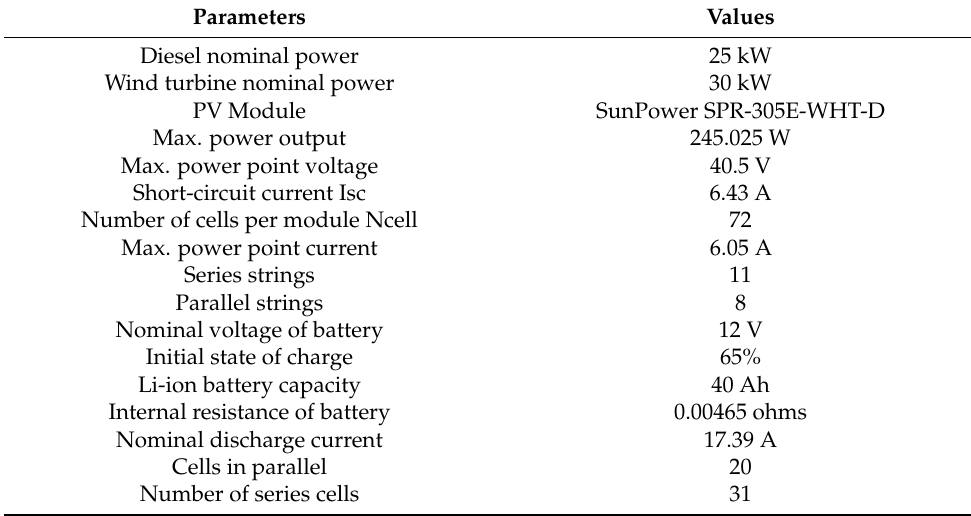
Table 1. Utilized parameters in micro-grid system simulations. Parameters